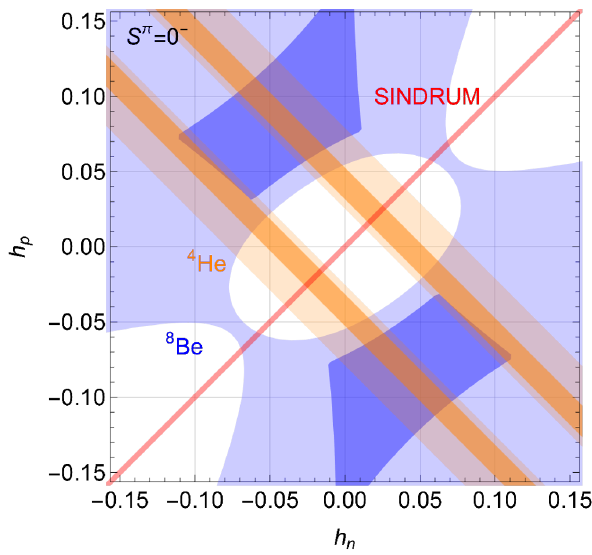
Figure 10 . Regions of the h n,p effective nuclear couplings of a pure pseudoscalar states where the 8 Be (blue) and 4 He (orange) anomalous ATOMKI transition can be explained at 1 σ or 2 σ . Inside the red region the SINDRUM bound is satisfied. Here both the 8 Be(18.15) and the 8 Be(17.64) transitions are